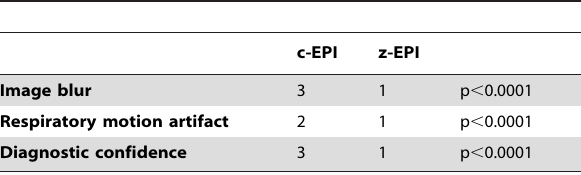
Table 4. Image quality scores (median) of both sequences for different